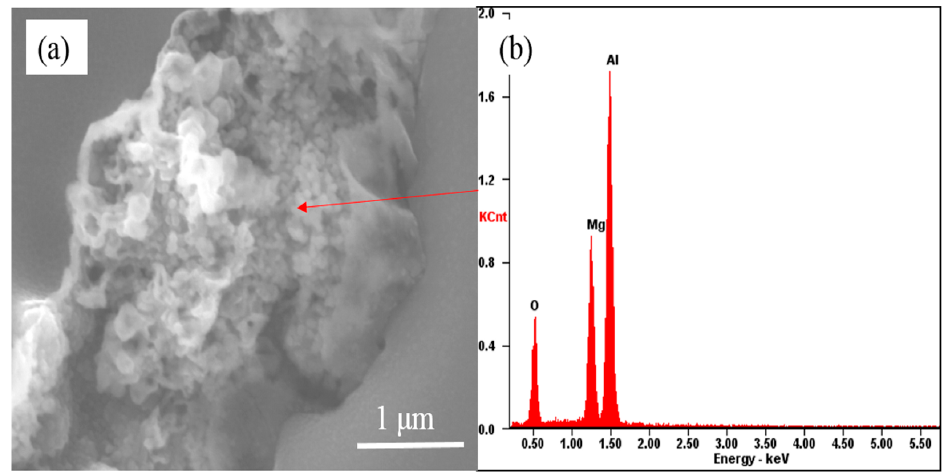
Figure 10. ( a ) The micro-morphology of 5083 alloy scraps after being held in the commercial pure aluminum melt for 15 min; ( b ) Corresponding EDS results.